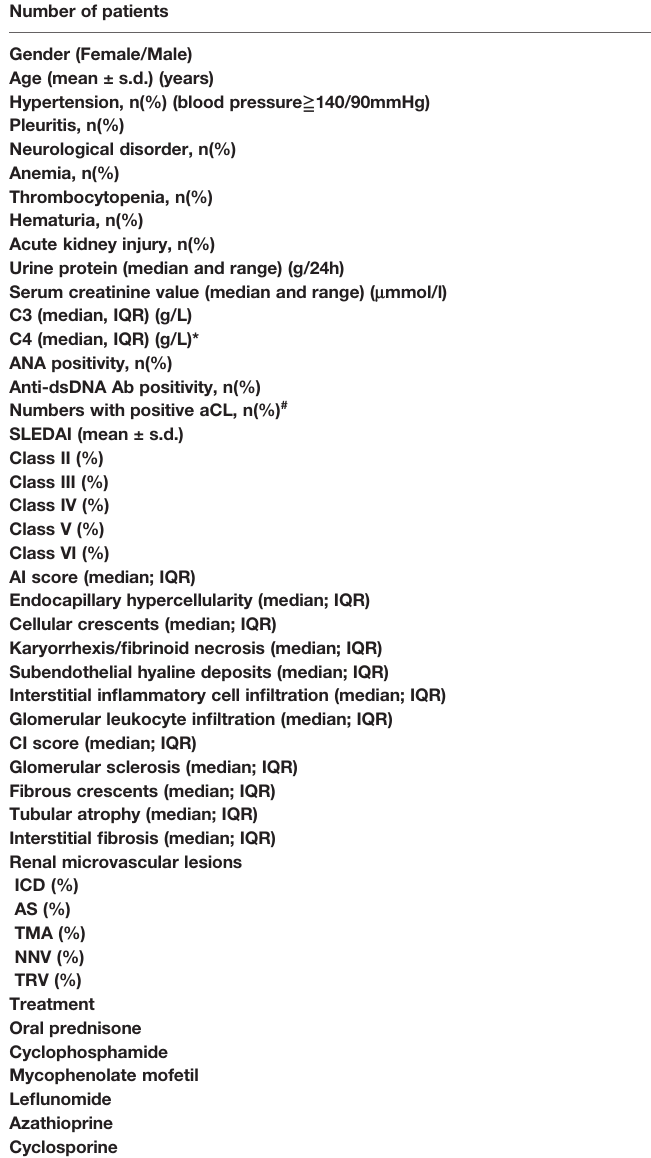
TABLE 1 | Baseline clinico-pathological data of lupus nephritis patients. Number of